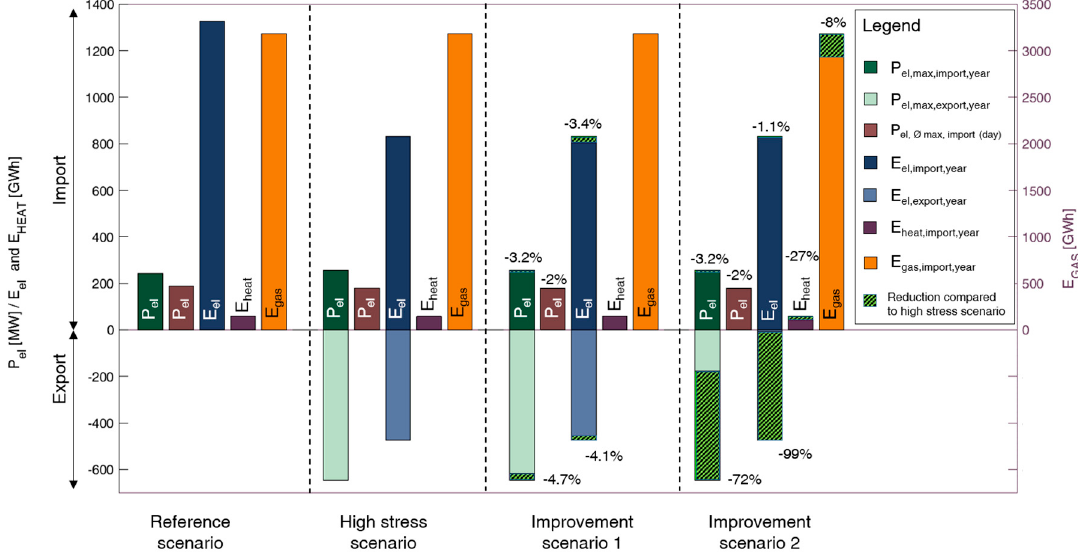
Figure 9. Results of all deployed scenarios of case study 2.